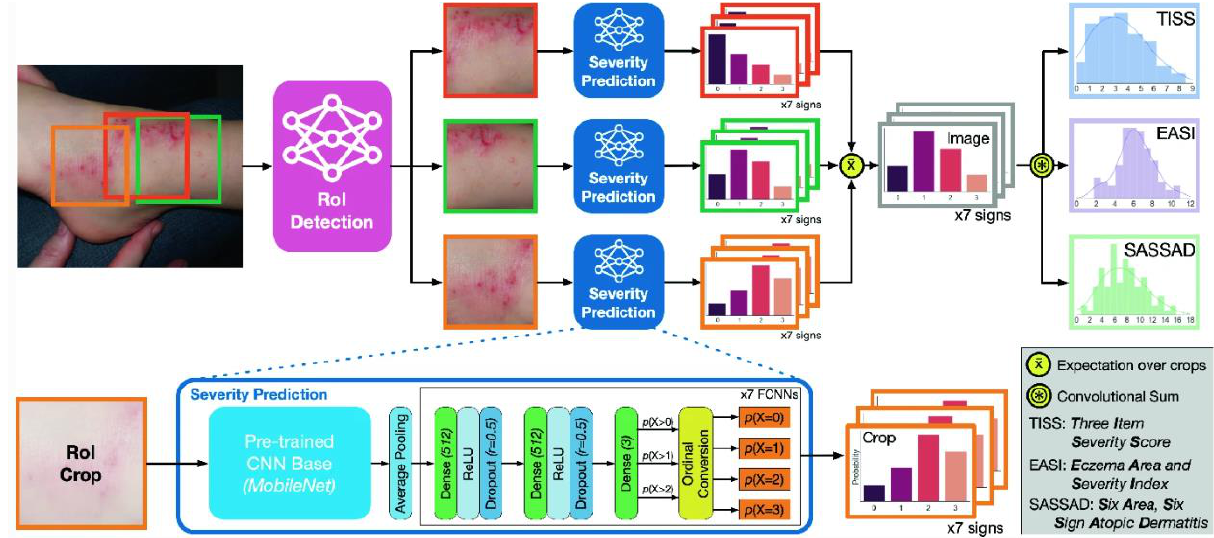
Figure 8. Schematic of the EczemaNet model created by Pan et al. The model can identify photographs of AD and predict the severity of the disease. Image reproduced with permissions from [83].